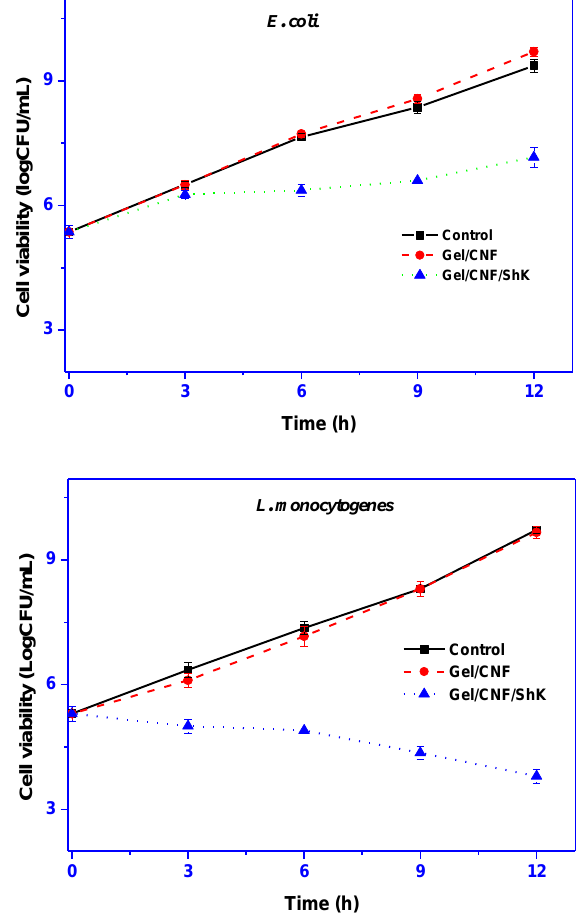
Figure 6. Antimicrobial activity of the film.